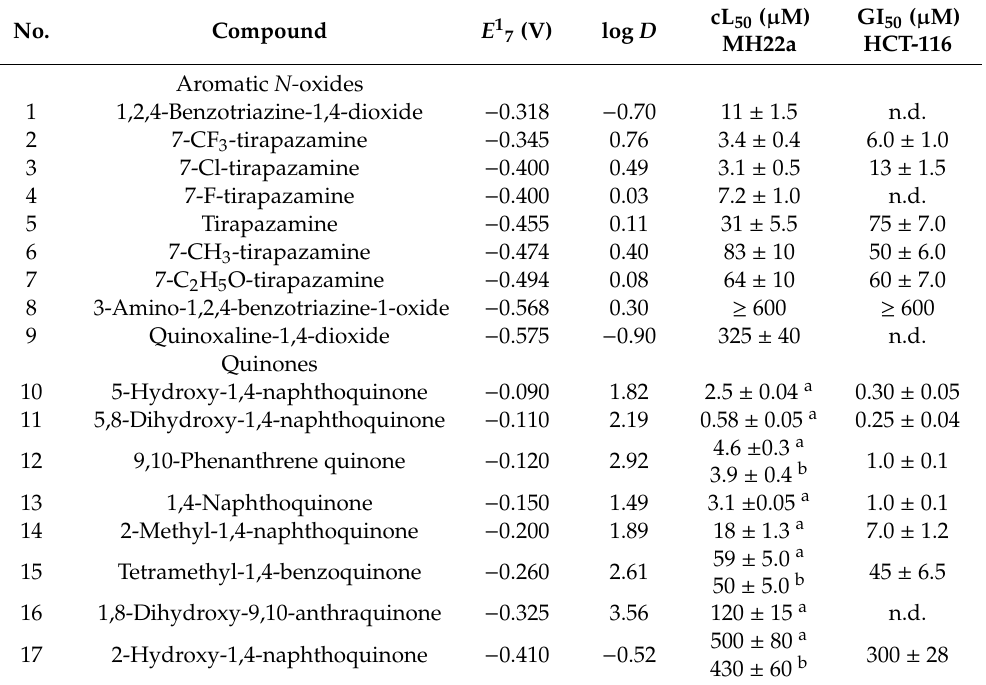
Figure 3. NAD(P)H:quinone oxidoreductase (NQO1)-catalyzed redox cycling of TPZ. The rates of NQO1-catalyzed oxidation of NADPH (1,2), depletion of TPZ (3), and reduction of cytochrome c (4-7) in the presence of 300 µ M NADPH. Additions: NADPH (1), NADPH + 300 µ M TPZ (2,3), NADPH + 50 µ M cytochrome c (4), NADPH + cytochrome c + 100 U / mL SOD (5), NADPH + TPZ + cytochrome c (6), NADPH + TPZ + cytochrome c + SOD (7), n = 3, p < 0.02 for 1 against 2 (*), for 4 against 5 (#), and 6 against 7 (**). Table 3. The single-electron reduction midpoint potentials ( E 1 7 ), octanol / water distribution coe ffi cients at pH 7.0 (log D ) of compounds, their concentrations for 50% cell survival (cL 50 ) in murine hepatoma MH22a cells, and in their concentrations causing 50% maximal proliferation inhibition (GI 50 ) of human colon adenocarcinoma HCT-116